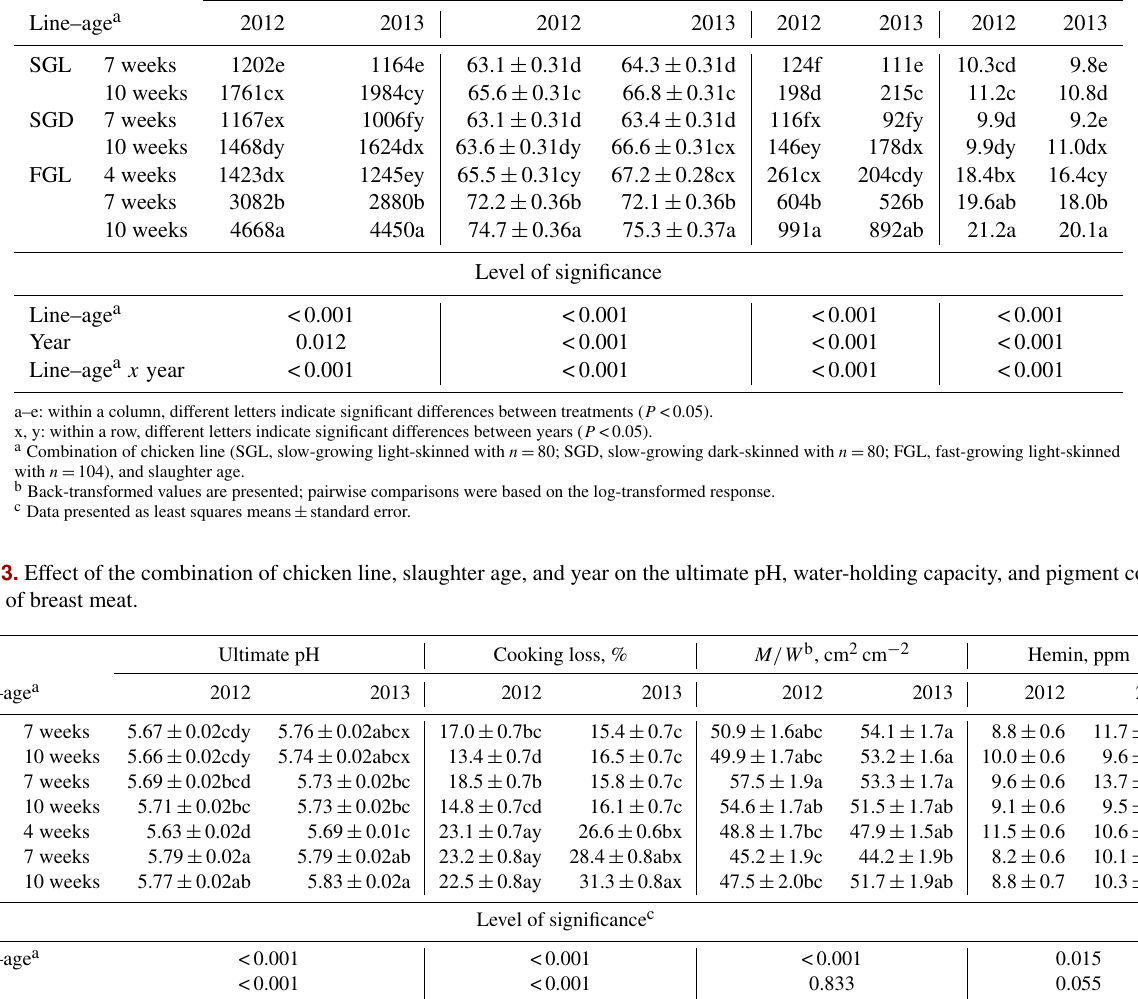
Table 2. Effect of the combination of chicken line, slaughter age, and year on body weight and carcass composition. Weight at slaughter b , g